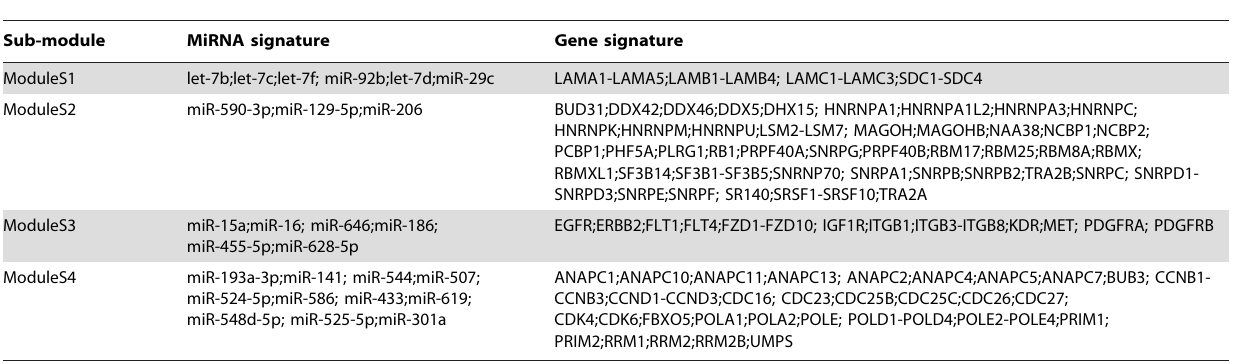
Table 2. The detailed composition information of four sub-modules in the glioma core survival